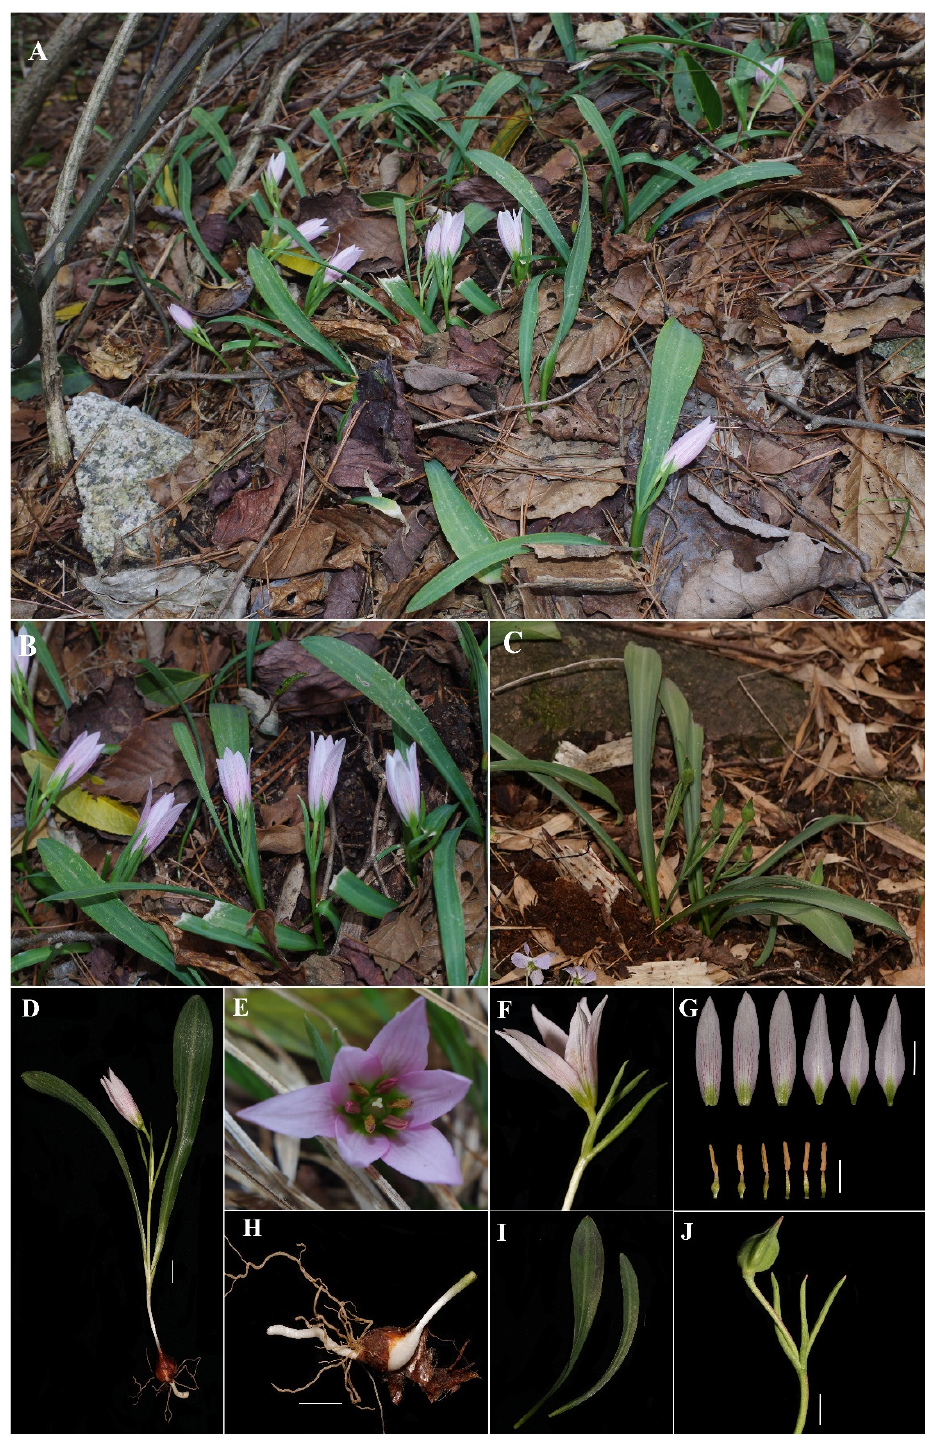
Figure 4. ( A – J ) Amana anhuiensis : ( A ) Habitat, ( B ) Population with flowers, ( C ) Population with fruits, ( D ) Whole plant, ( E ) The front view of the flower, ( F ) The side view of the flower, ( G ) Anatomy of flower, ( H ) Bulb, ( I ) Leaves, ( J ) Fruits. The white line segment represents a length of 1 cm.